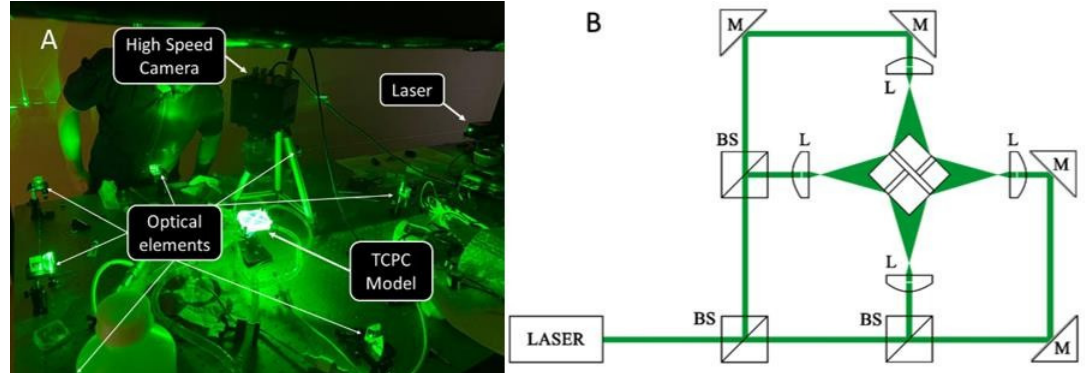
Figure 4. ( A ) Photo of the experimental bench and ( B ) optical scheme of the experimental bench, where BS is beam splitters, M—mirrors, L—cylindrical lens.